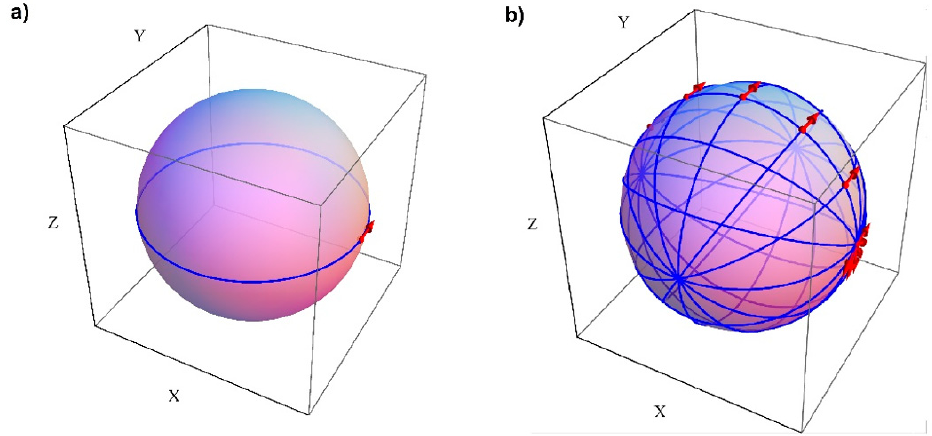
Figure 3. Measurement strategies used in the experiment: ( a ) the traditional strategy; ( b ) the new strategy.